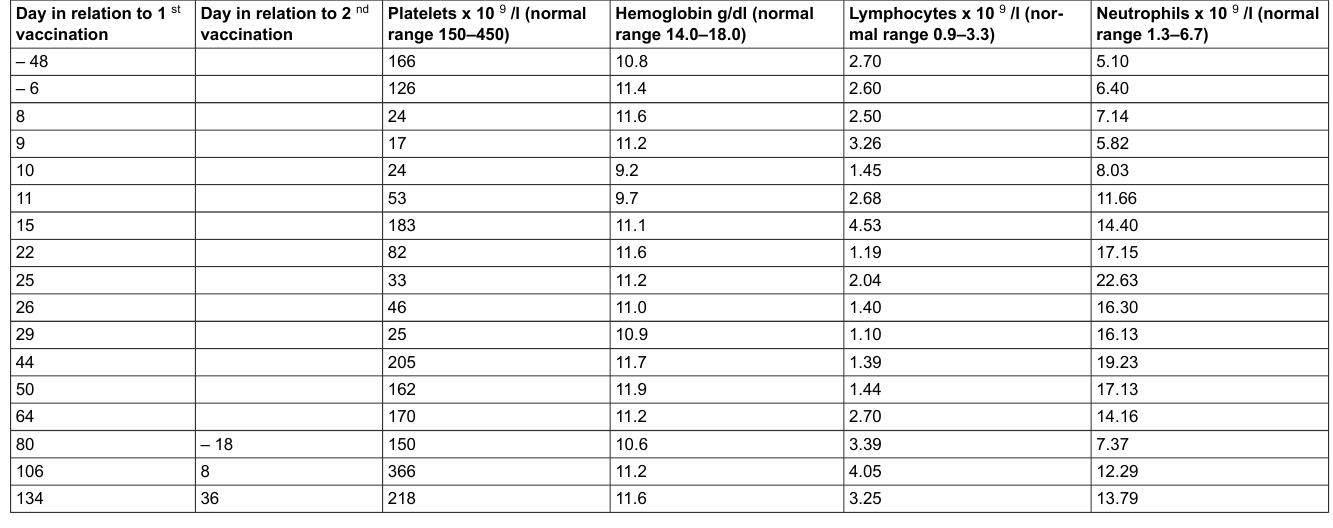
Table 1: Time course of platelet count, haemoglobin, lymphocytes and neutrophilis before, during and after COVID-19 vaccination and ITP therapy. The second vaccination took place on day 98 in relation to the first vaccination. Day in relation to 1 st Day in relation to 2 nd vaccination